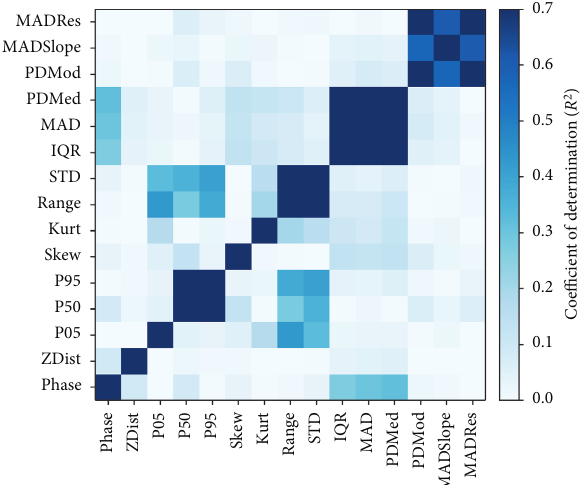
Figure 4: Correlation between features. Darker color represents a higher coefficient of determination ( R 2 ) between two